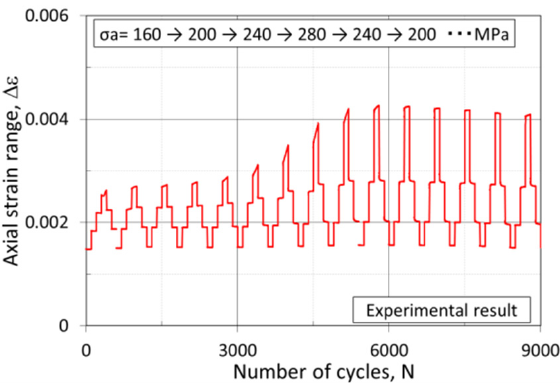
Figure 7. Experimental relationships between ∆ ε and the number of cycles under increasing and decreasing amplitude loading test.